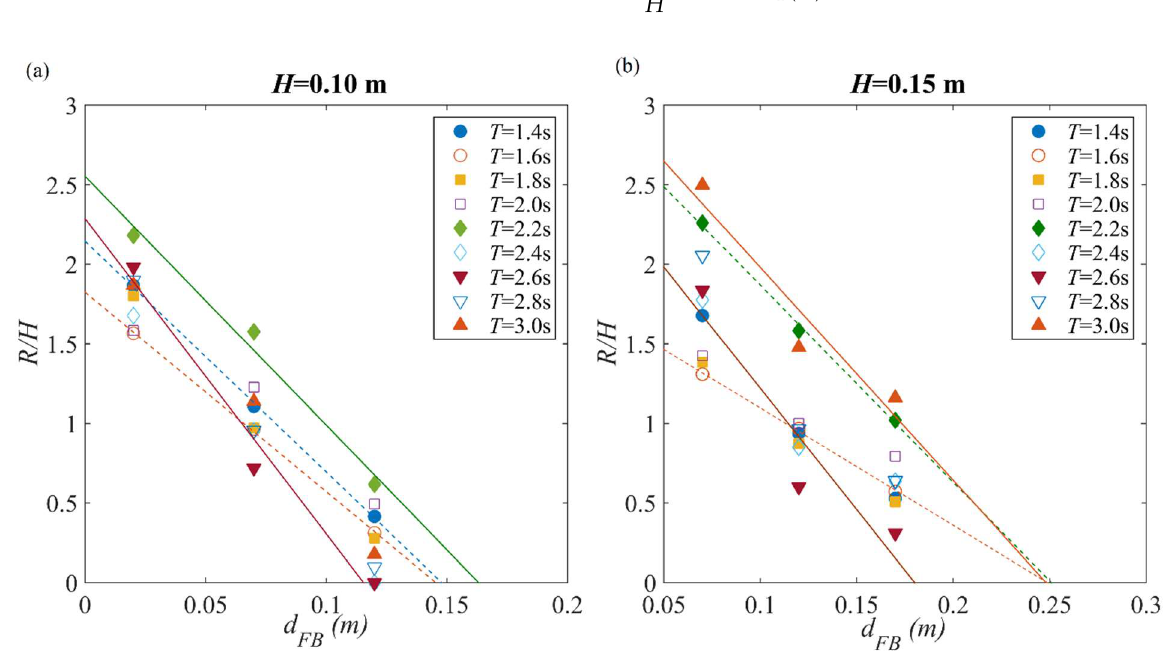
Figure 11. Linearized relationship between freeboard height d FB and wave run-up RAO R / H , linear fitting curves shown with corresponding colour of the data, ( a ) H =0.10m; ( b ) H =0.15m